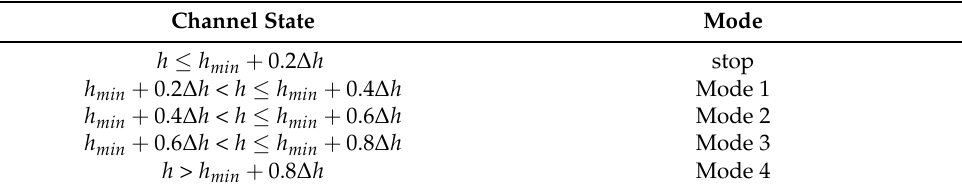
Table 4. Channel-based adaptive modulation and coding